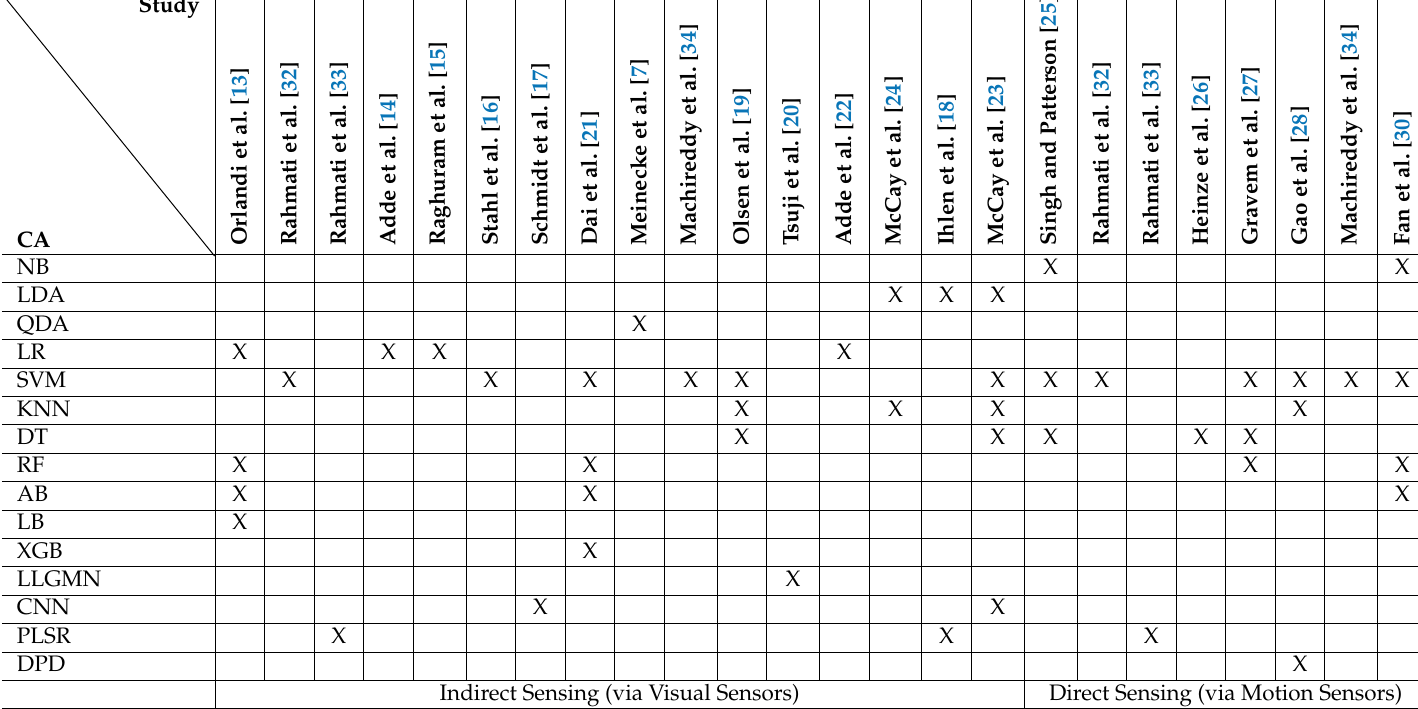
Table 3. The list of classification algorithms used for the assessment of GMs and